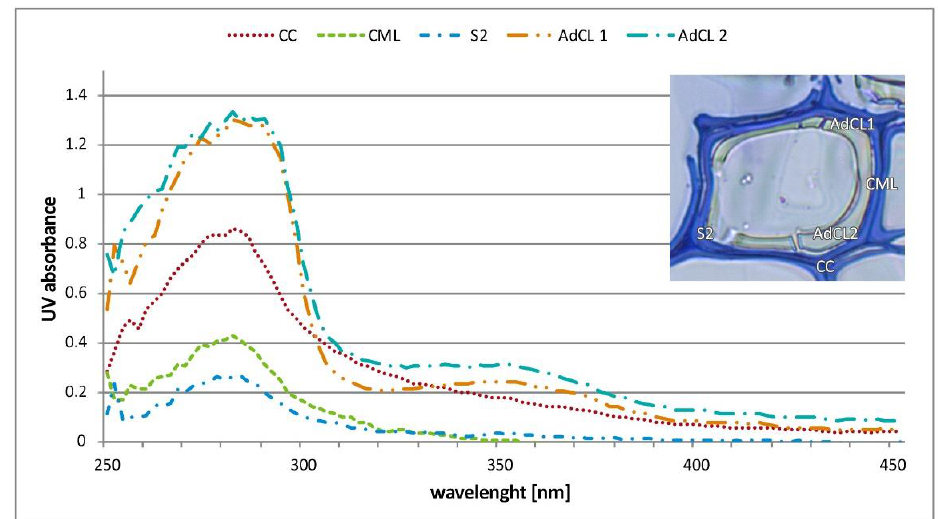
Figure 8. UV absorbance spectra of individual cell wall layers and cell lumen-deposited phenolic adhesive in the wooden tissue of PM 3 (AC 19%) (CC—cell corner, CML—compound middle lamella, S2—secondary wall, AdCL1 and AdCL2—adhesives attached to cell lumen). Looking at the mean values only, it suggests an increase in SC with decreasing parti- cle size (Figures 11 and 12). Only the smallest sieve fraction (<0.8 mm) does not follow this